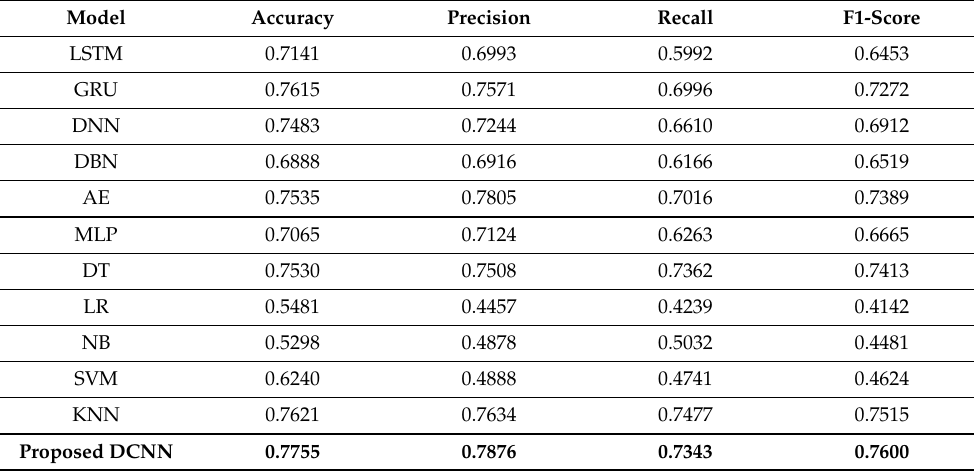
Table 10. A comparison of DCNN with other DL models on multi-class